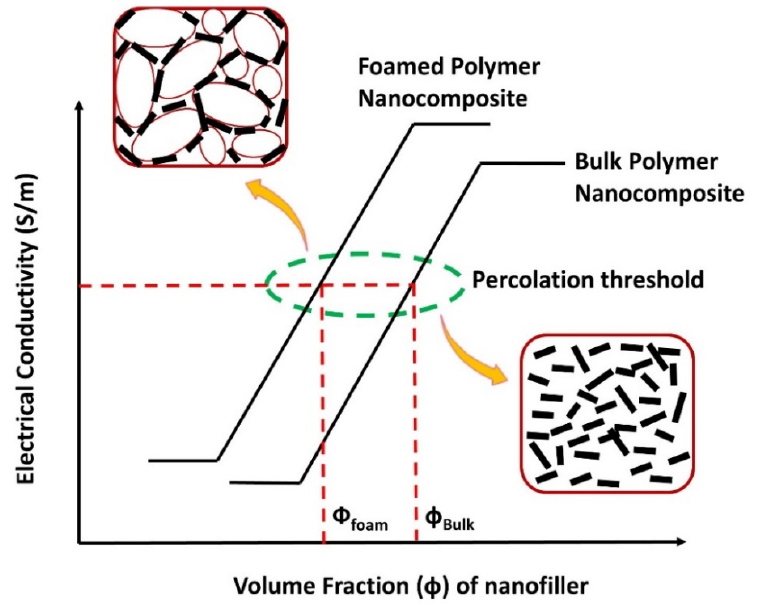
Figure 4. Schematic comparison of percolation behavior in bulk and porous polymer nanocompo- sites.